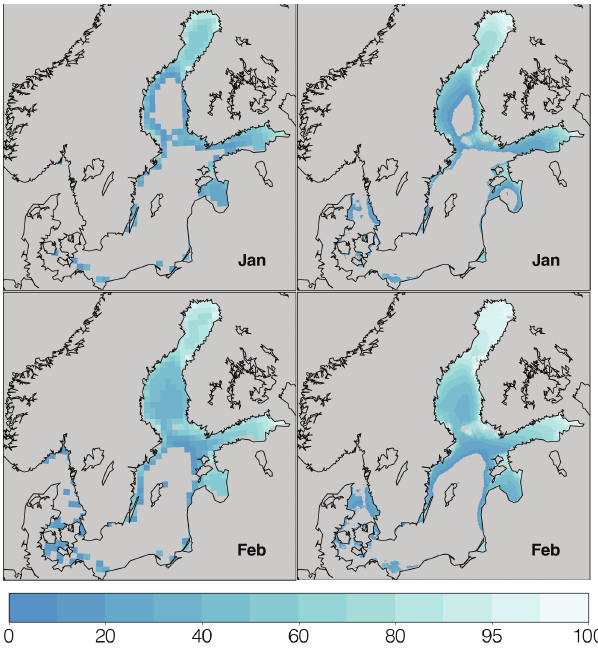
Figure 6. Climatological mean ice concentration for January and February, for the period 1961/1962–1978/1979. The left column shows the sea-ice concentration for BASIS and the right column that for NEMO-Nordic. Note that grid cells with an ice concentra- tion lower than 15% have been masked out and that grey sea areas denote missing or masked values.